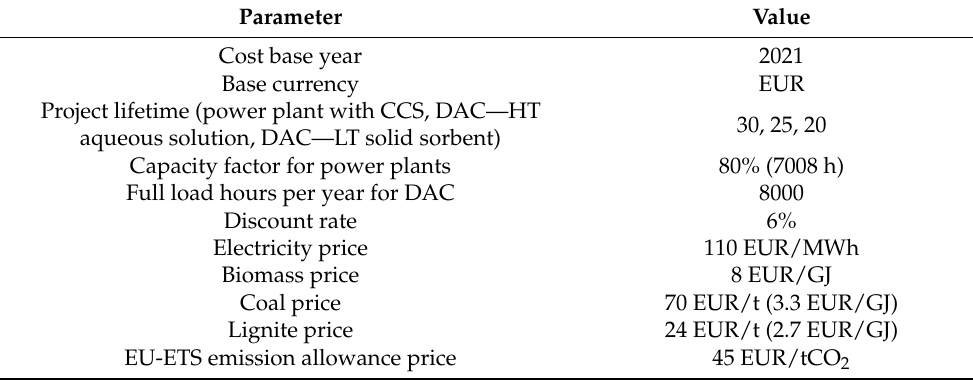
Table 5. Summary of financial assumptions.